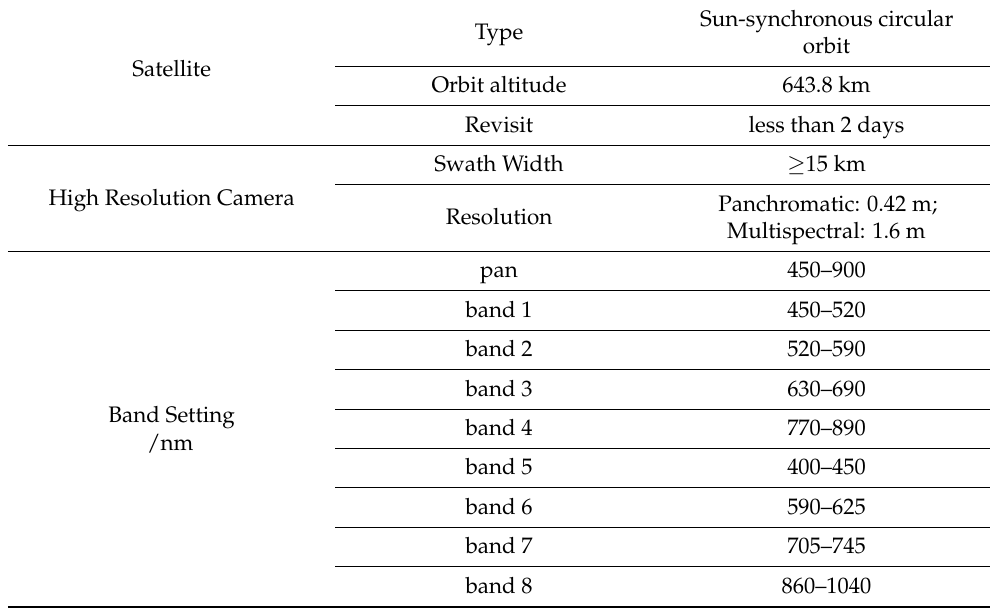
Table 1. Parameters of GFDM